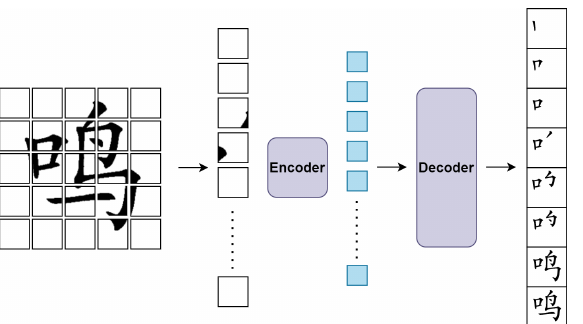
Figure 1. Our SAE architecture based on Vision Transformer. The encoder is applied on the image patches of the Chinese characters (we take ‘ 鸣 ’ for example). The decoder reconstructs the stroke sequence images (the order of strokes) from the encoded